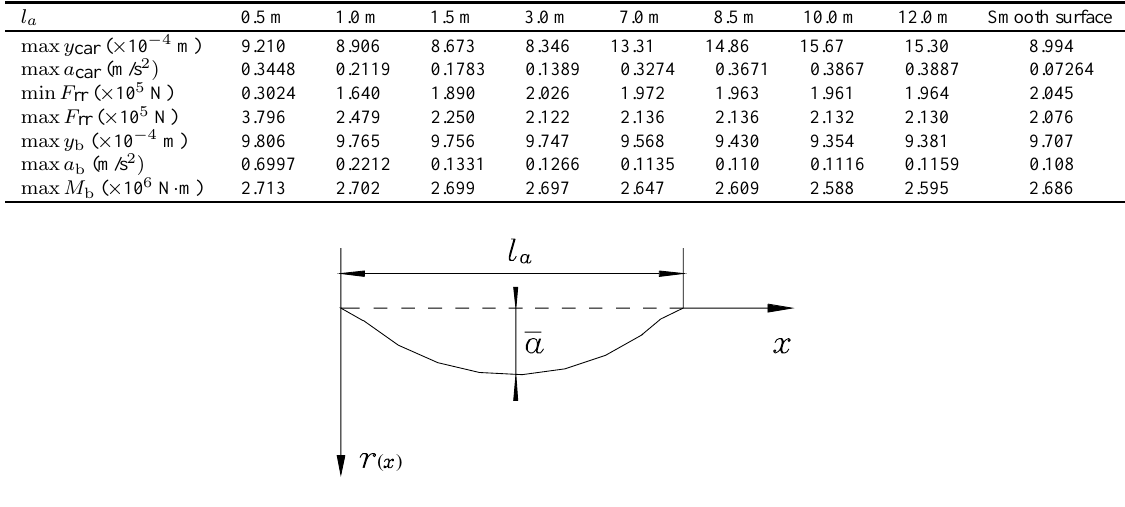
Fig. 7. Model of irregularity on bridge